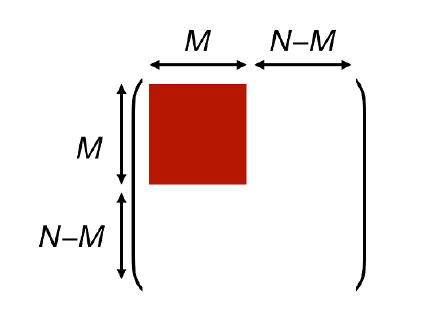
Figure 2. Matrix representation of the partial decon(cid:12)nement proposal [24, 30, 31]. The matrix represents a U( M ) subgroup of the U( N ) gauge group which is ‘decon(cid:12)ned’. Hence the full gauge group is only ‘partially